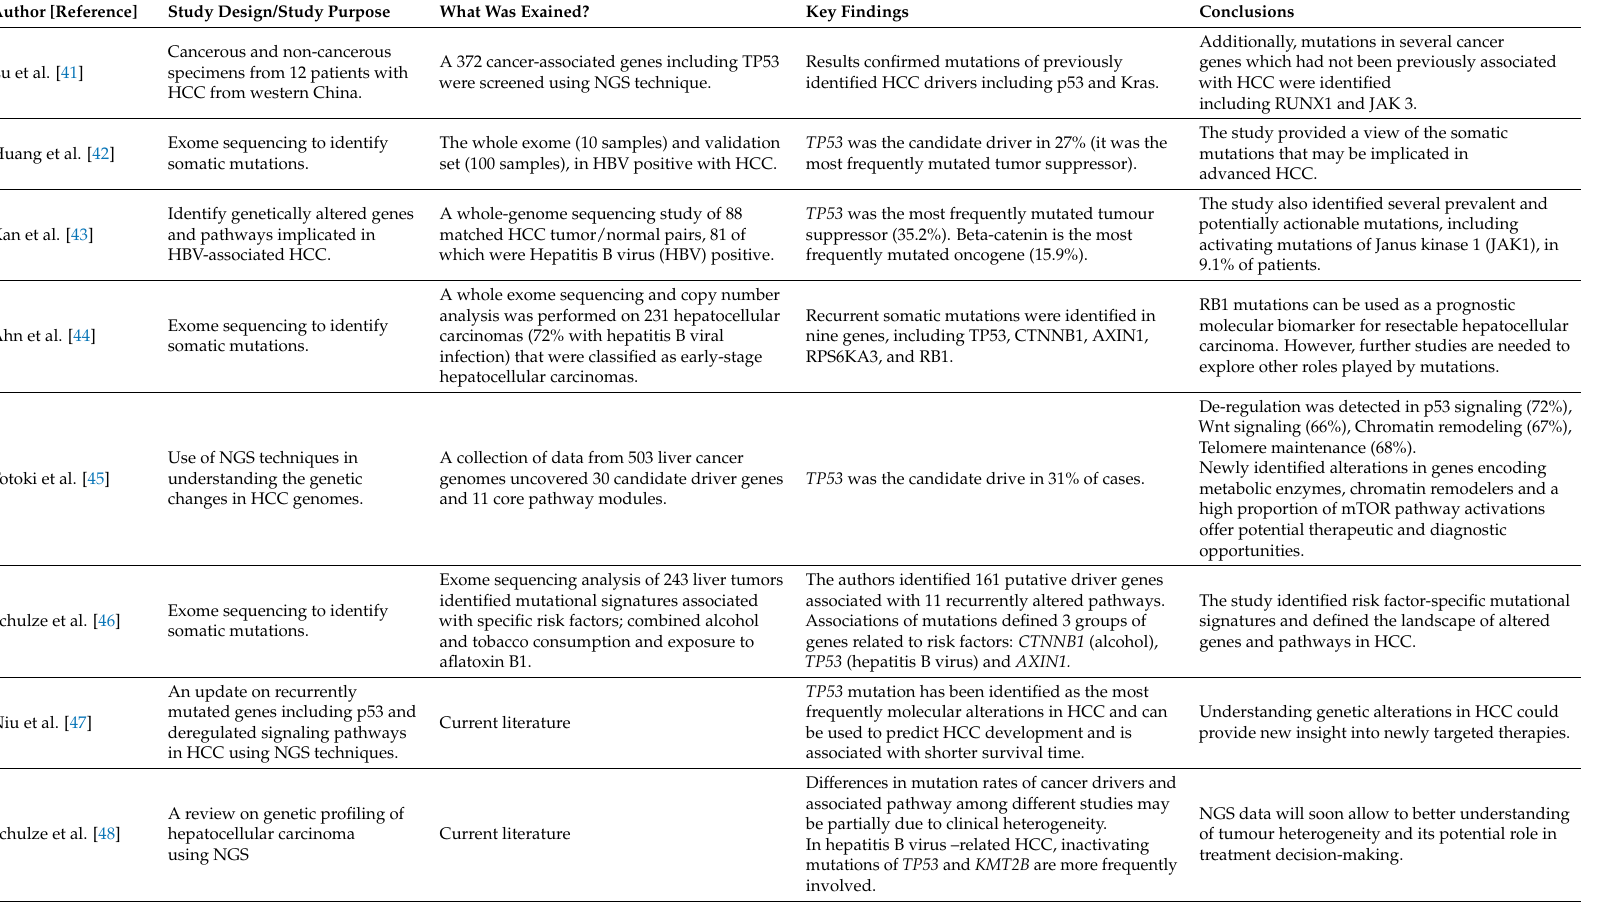
Table 1. Summarizes the role of p53 mutation in human hepatocellular carcinoma (HCC) in light of the recent studies using next generation sequencing (NGS)